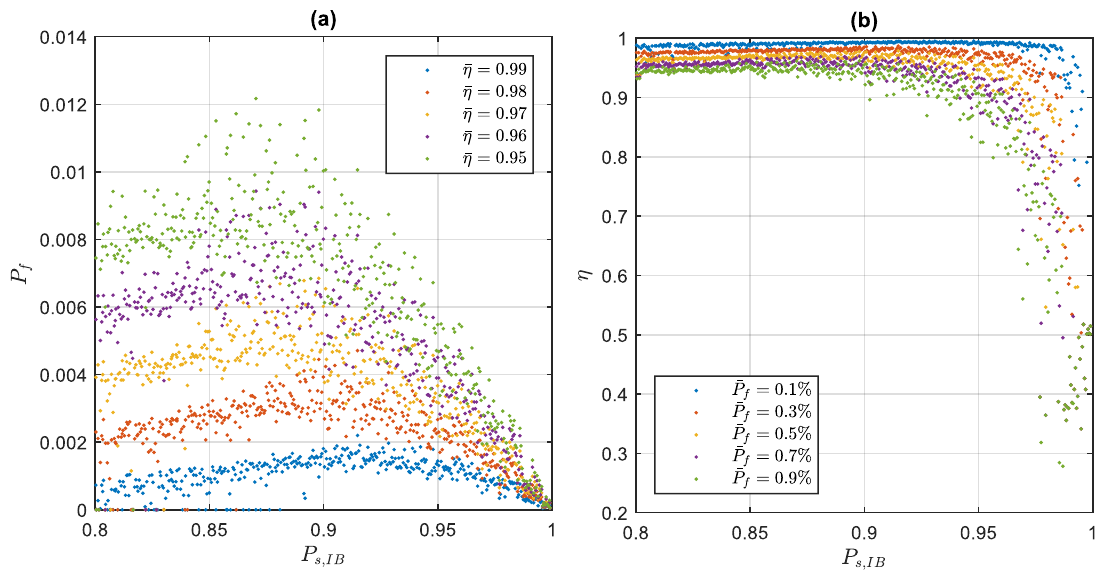
Figure 6. The f ailure rate of the FL-approach ( a ) and ( ) x  distribution of the FF-approach ( b